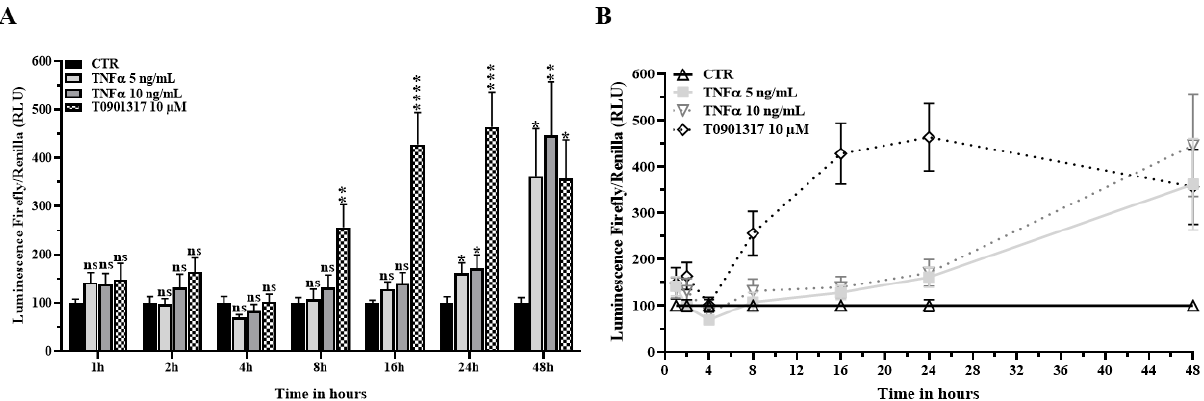
Figure 3. TNFα activates the LXR signaling pathway. ( A ). HBP were transfected with an LXR signal reporter assay. T0901317 was used as a positive control for LXR activation. Luminescence was meas- ured after 1, 2, 4, 8, 16, 24, and 48 h of TNFα treatment. Each bar represents the mean ± SEM of three independent experiments within three replicates each (N = 3; n = 9). ( B ) . Results are plotted